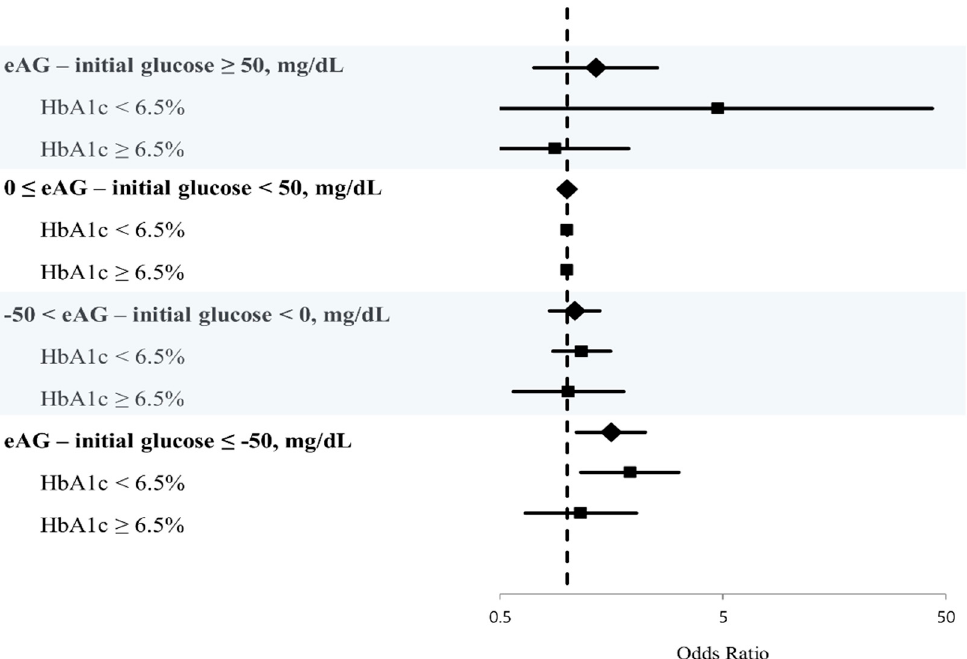
Figure 3. Logistic-regression plot of odds ratios and 95% confidence intervals. Effects of glucose gap on short-term stroke outcomes stratified by glycemic control status.